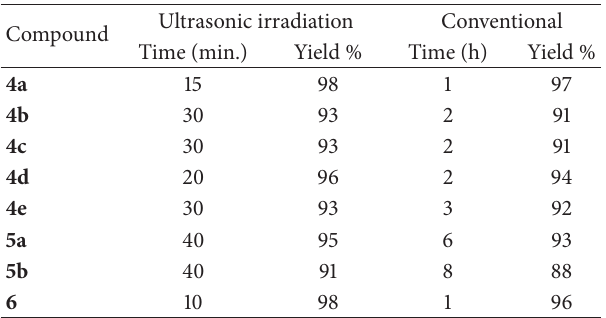
Table 1: Synthesis of Schiff’s bases derivatives 4a – e , 5a , 5b , and 6 both under ultrasonic irradiation and using the conventional